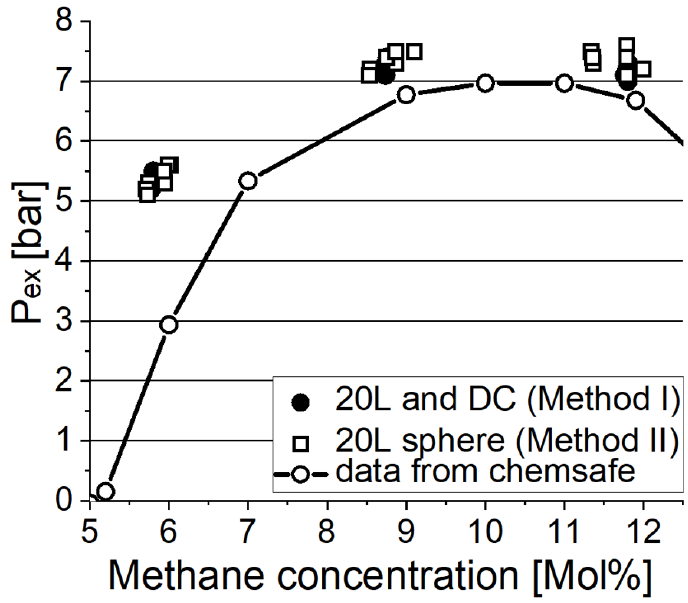
Figure 5. Explosion overpressure of methane; two different mixing procedures with gas inside the 20 L-sphere only and in the 20 L-sphere and the dust container (DC) and data from reference database [34].